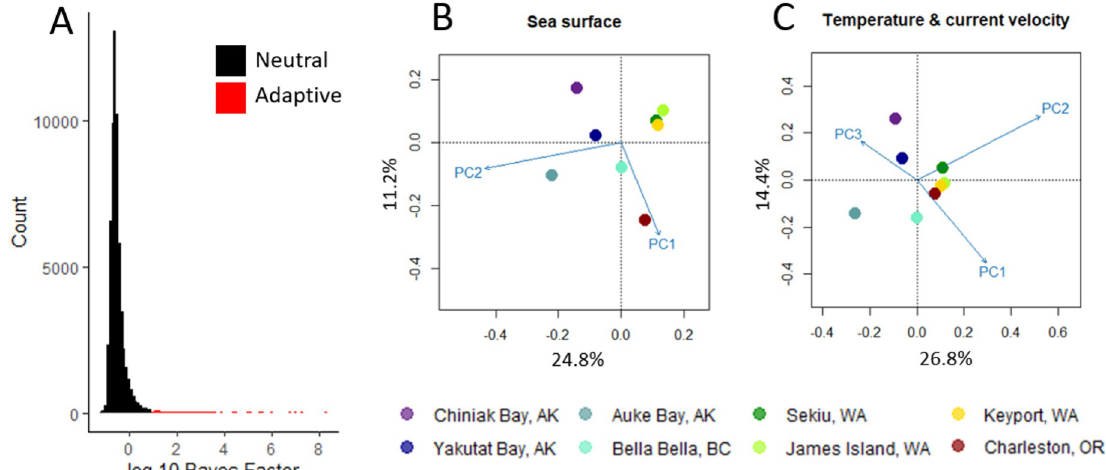
Fig 5. Summary of the results of univariate (Bayenv2) and multivariate (RDA) gene-environment associations. Panel A is a histogram of log10 Bayes Factors for each combination of SNP and environmental predictor. Panel B and C are RDA biplots of the first two RDA axes, with predictors as vectors and sites as points in ordination space, using Type 1 scaling, a scaling method appropriate for questions related to distance among objects. Panel B is of the retained model using sea surface predictors, and panel C is of the retained model using temperature and current velocity predictors. For each RDA biplot, the proportion of variance explained by each RDA axis is labeled on the axis.